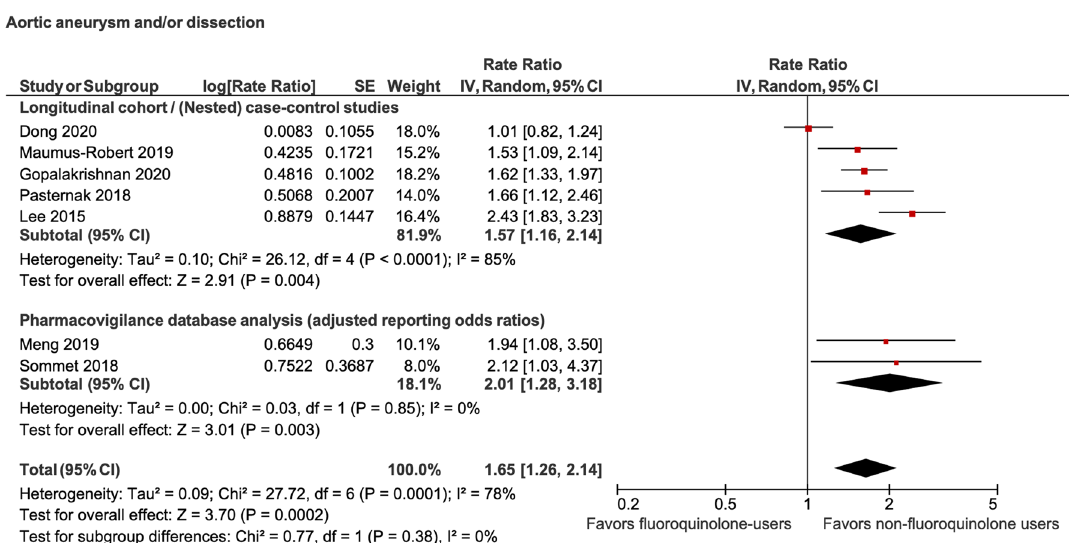
Figure 4. Association between fluoroquinolone use and aortic dissection or aortic